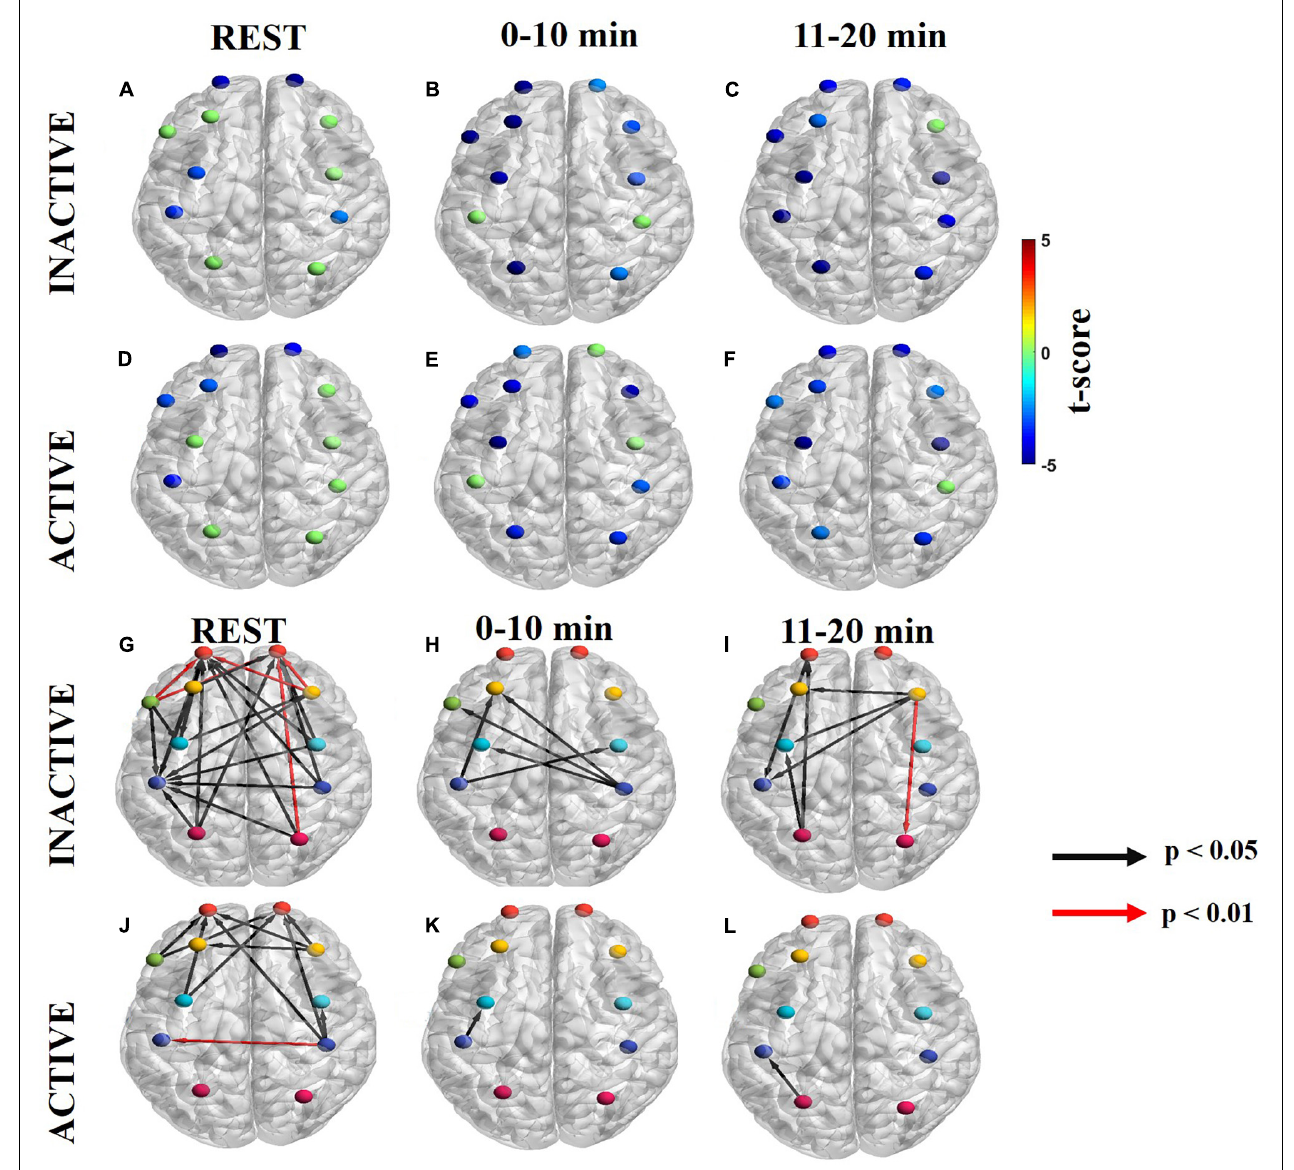
FIGURE 5 | Significant dPTE and DC in the myogenic frequency band for inactive and active subjects during the handgrip task for (cid:49) HbO. Directed PTE t -values for each ROI as a color-coded map for inactive subjects (A–C) and active subjects (D–F) . Hot (yellow-reds) and cold (light blue-dark blue) colors indicate information outflow and inflow, respectively. Arrows indicate statistically significant information flow between functional regions for inactive (G–I) and active subjects (J–L) . Black arrows ( p < 0.05); Red arrows ( p < 0.01). Eleven regions of interest (ROIs) were mapped: left and right frontopolar (lFP; rFP) (red), left and right pre-frontal cortex (lDLPFC; rDLPFC) (yellow), Broca’s area (green), left and right pre-motor cortex (lPMC; rPMC) (light blue), left and right primary motor and sensory cortical (lM1/S1; rM1/S1) areas (purple), and left and right sensory association cortex (lSAC; rSAC)